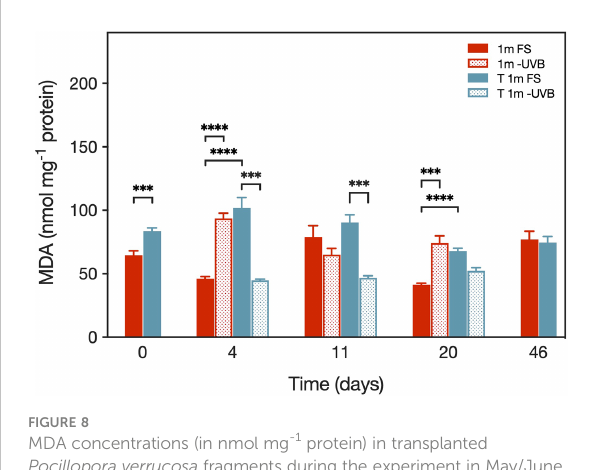
FIGURE 8 MDA concentrations (in nmol mg -1 protein) in transplanted Pocillopora verrucosa fragments during the experiment in May/June 2019. Values are means (n=10) ± SEM. Asterisks indicate cases where the Tukey ’ s post hoc test identi fi ed signi fi cantly different means between treatments at levels p < 0.001 (***) and p < 0.0001 (****).